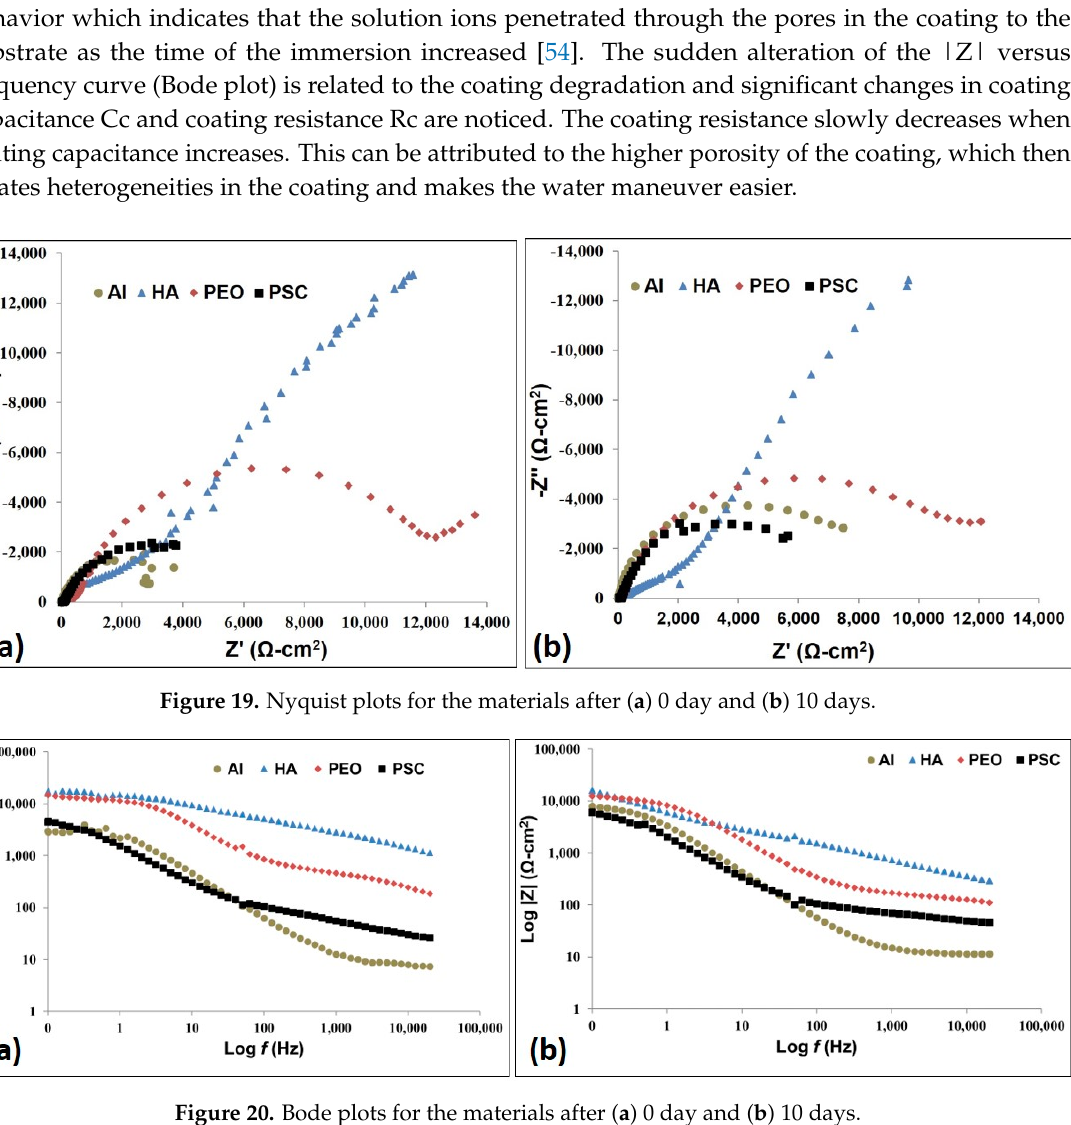
Figure 20. Bode plots for the materials after ( a ) 0 day and ( b ) 10 days.